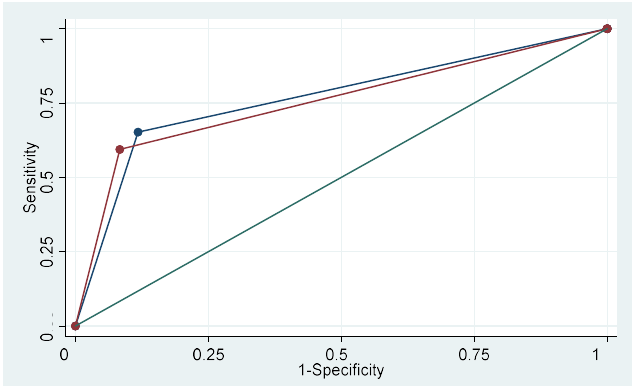
Figure 2. FDG-PET/CT performance according to the histological type.